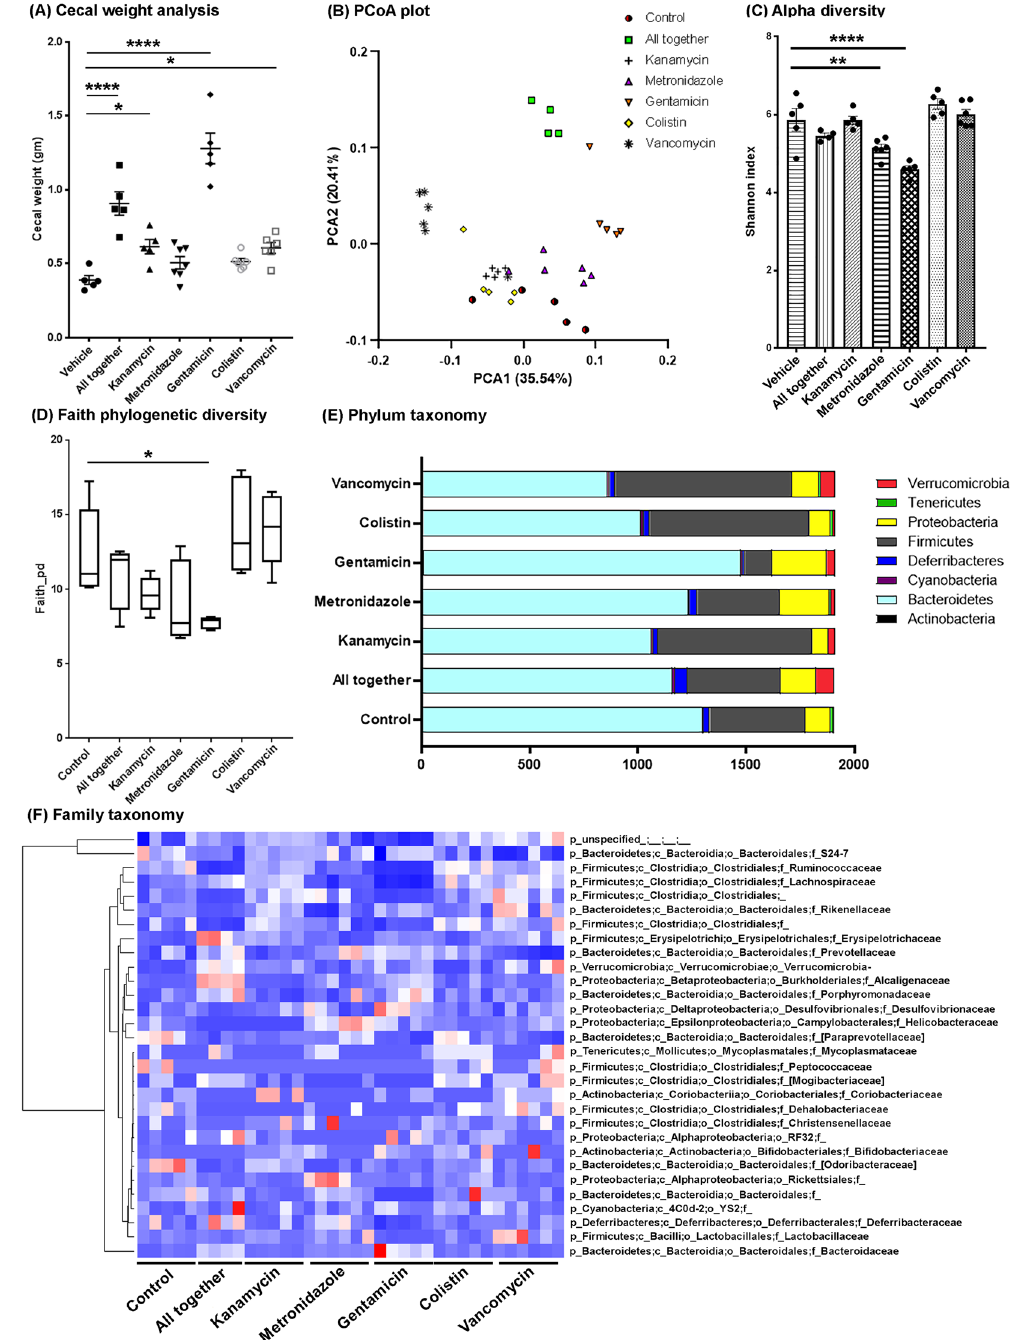
Figure 1. Cecal weights and microbiome profile is altered after individual or combinatorial ABX (ABX- cocktail) at 9 weeks of age. ( A ) Cecal weights from vehicle-, ABX-cocktail or individual ABX-treated male mice. One-way ANOVA showed significant differences among groups (F(6,32) = 29.2, P < 0.0001). Post-hoc analysis showed ABX cocktail (“All together”) ( P = 0.0001), kanamycin ( P = 0.045), gentamicin ( P = 0.0001) and vancomycin ( P = 0.044) treatment resulted in significantly larger cecal weight compared with control. N = 5 control (vehicle), n = 5 kanamycin, n = 7 metronidazole, n = 5 gentamicin, n = 6 colistin, n = 6 vancomycin, n = 5 abx cocktail treated male mice. ( B ) PCoA plot of abundance-weighed Unifrac distances, a metric of beta diversity. The two components (PCA1, PCA2) explained 35.54% and 20.41% of the variance, respectively. ABX cocktail showed a clear separation compared with the control mice. Gentamicin- and vancomycin- treated-mice also showed a clear separation compared with control. ( C , D ) Alpha-diversity differed significantly across groups (One-way ANOVA: F(6,29) = 15.45, P < 0.0001) and was measured using the Shannon diversity index, which accounts for both community evenness and richness. Specifically, metronidazole ( P < 0.0001) and gentamicin ( P < 0.0001)-treated groups showed significantly reduced alpha diversity compared to control. ( D ) Phylogenetic richness also differed significantly across groups (One-way ANOVA: F(6,29) = 5.814, P = 0.0005) and